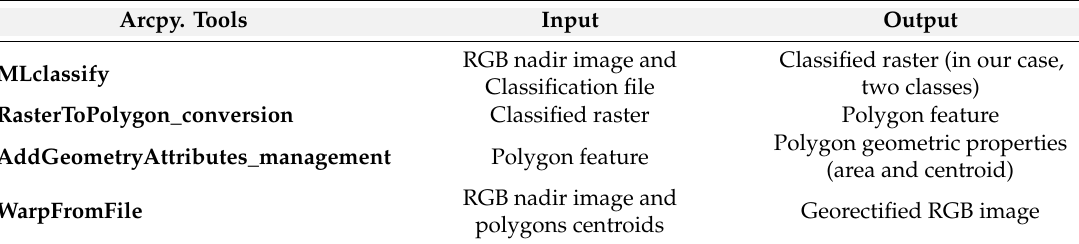
Table 4. The main ArcPy and ArcMap tools used to process the RGB